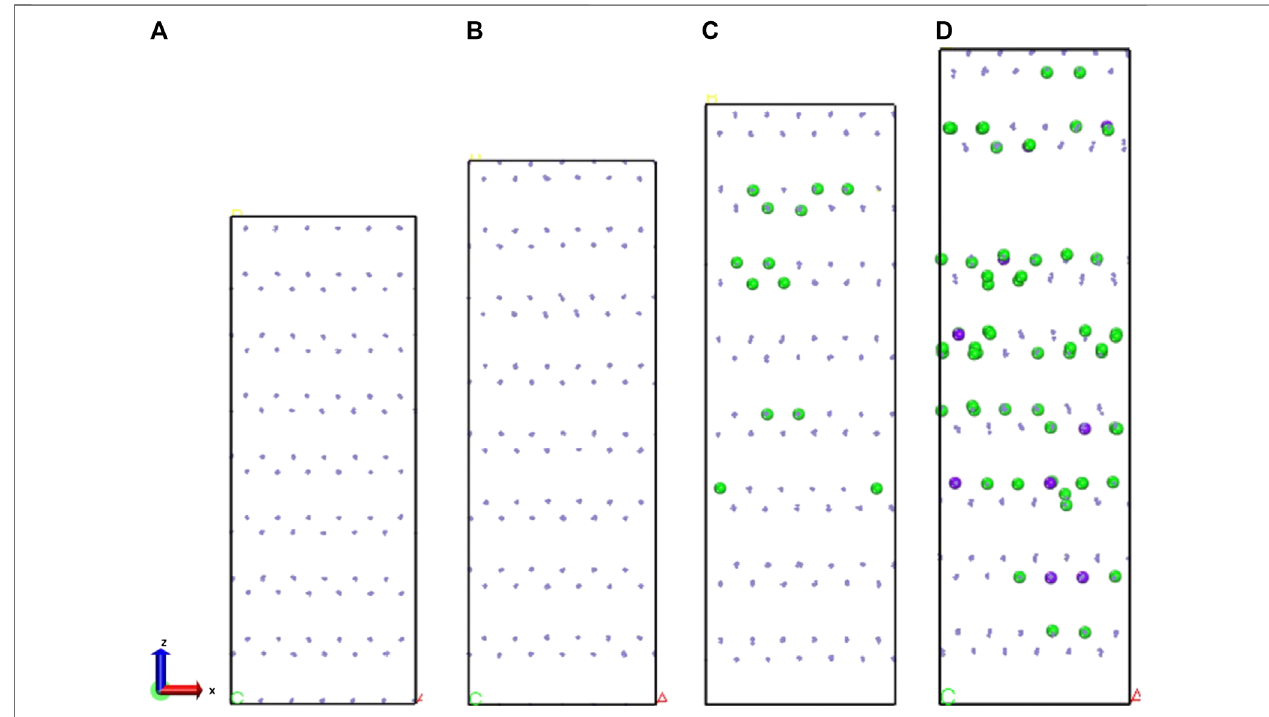
FIGURE12|(A) 100 ps, (B) 200 ps, (C) 400 ps,and (D) 600 ps γ -FeOOHstructureinthe z -directionstretchingwhentheFeatomcoordinationlocalvariation.The green sphere represents iron with a coordination number of 4, and the purple sphere represents iron with a coordination number of 2.